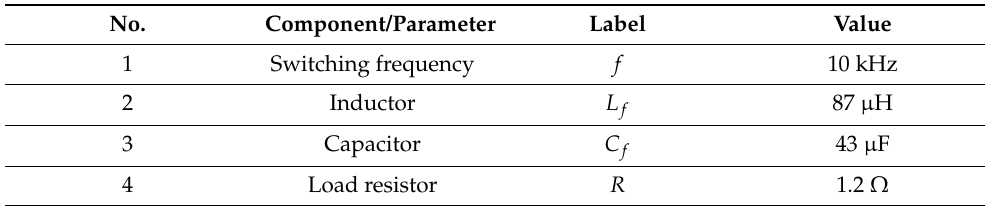
Table 3. Buck Converter